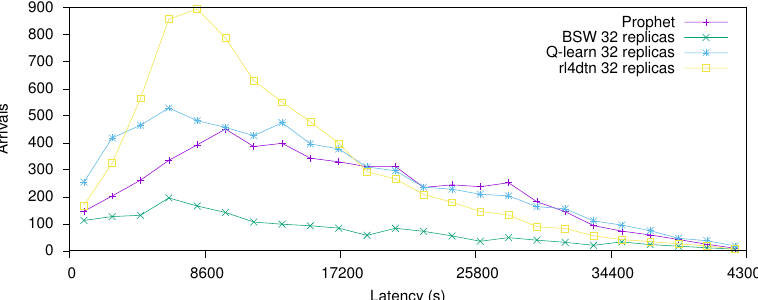
Figure 7. Message latency